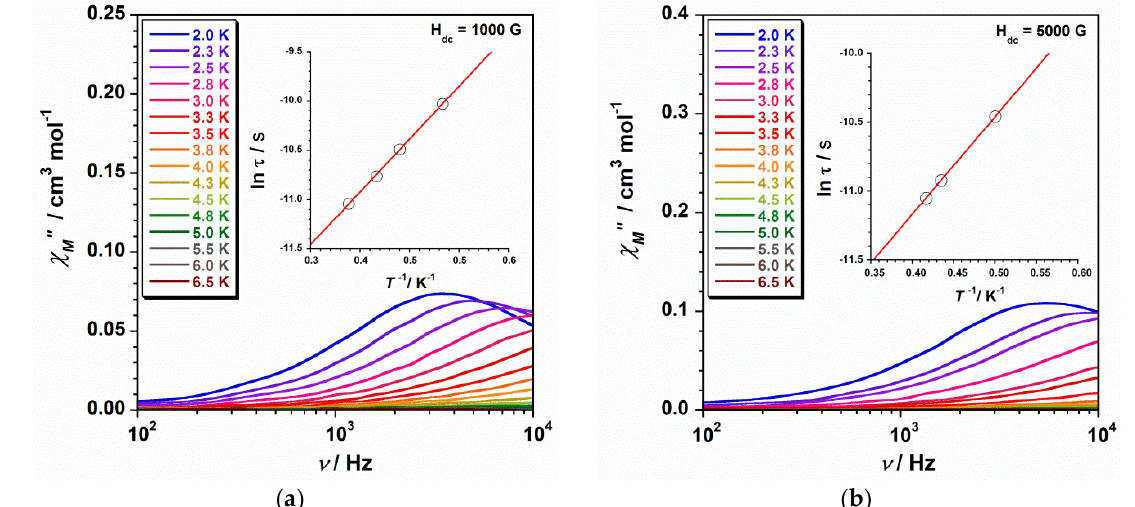
Figure 4. Frequency dependence of the out-of-phase ac susceptibility signals under dc fields of 1000 ( a ) and 5000 G ( b ) for compound 1 . The respective inset shows the ln(τ) versus 1/T plot for 1 with the fit to the Arrhenius law (dashed line) and the fit considering several mechanisms (solid line).